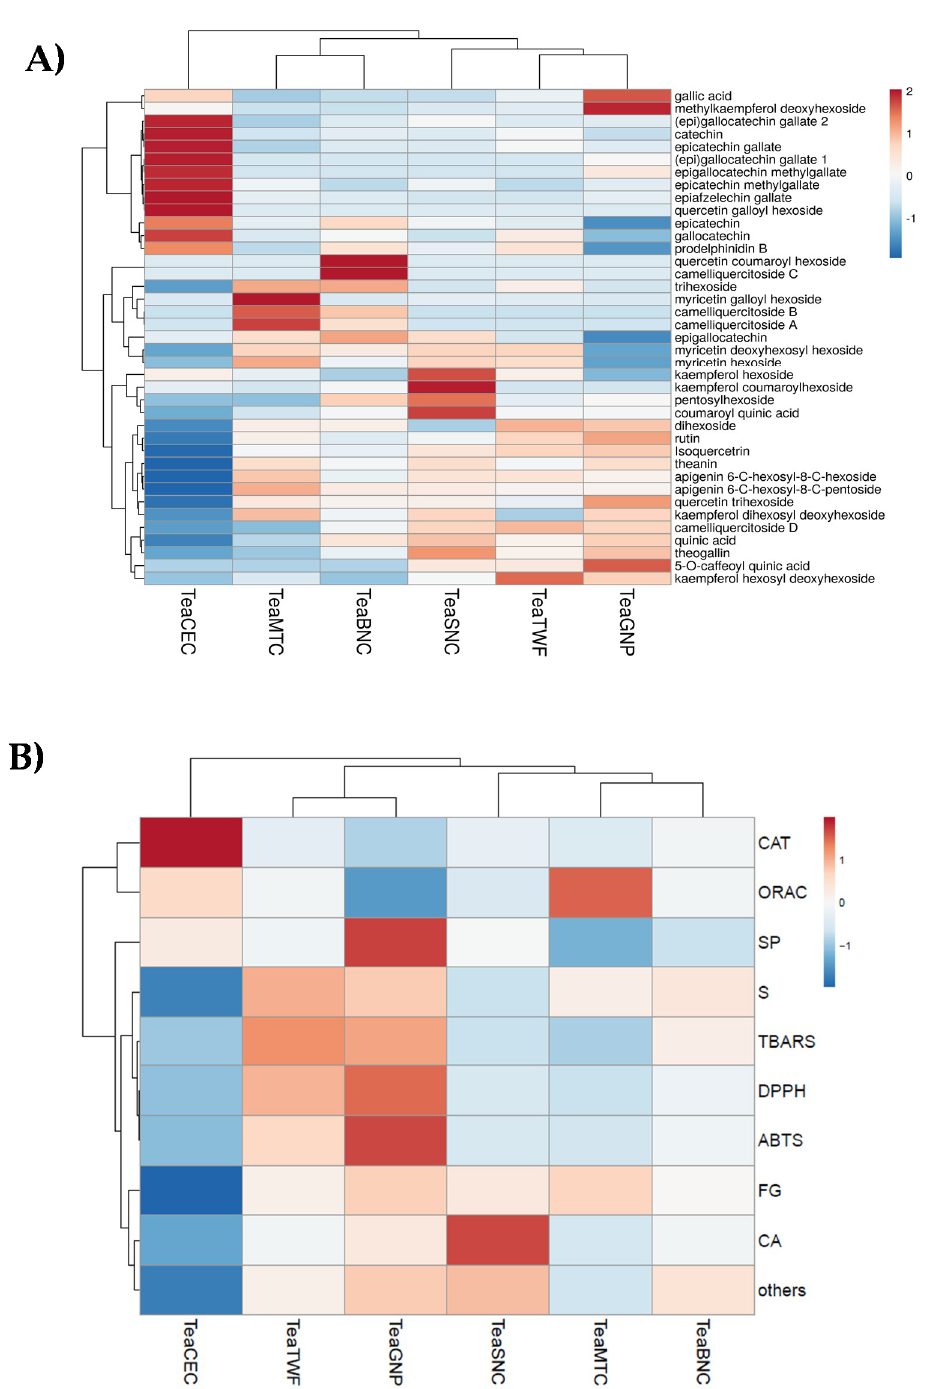
Figure 8. Heatmap ( A ) of compounds tentatively identified in alcoholic tea extracts; ( B ) relative content of each class of compounds (S = Sugars, SP = Simple Phenols; CA = Chlorogenic Acids; CAT = Catechins; FG = Flavonol Glycosides; “others” is for theanin and quinic acid). Annotations on top of the heatmap show clustering of the tea samples. In the ClustVis hierarchical clustering tool, both rows and columns are clustered using correlation distance and average linkage